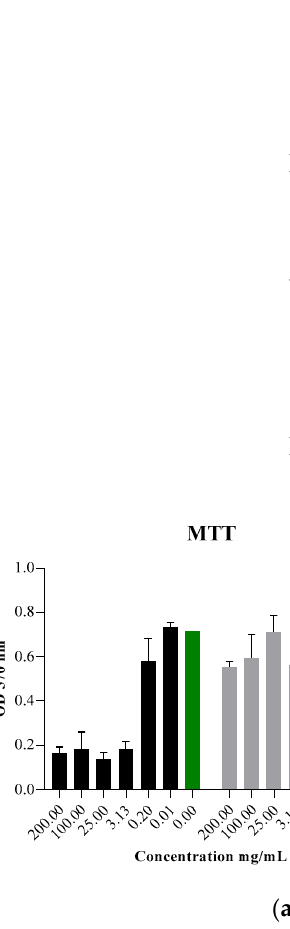
Figure 1. ( a ) Logarithmic reduction and ( b ) Population reduction in Staphylococcus aureus ATCC 6538, Escherichia coli ATCC 8739, and Candida albicans ATCC 10,231 strains by tested samples represented by novel nutraceuticals.